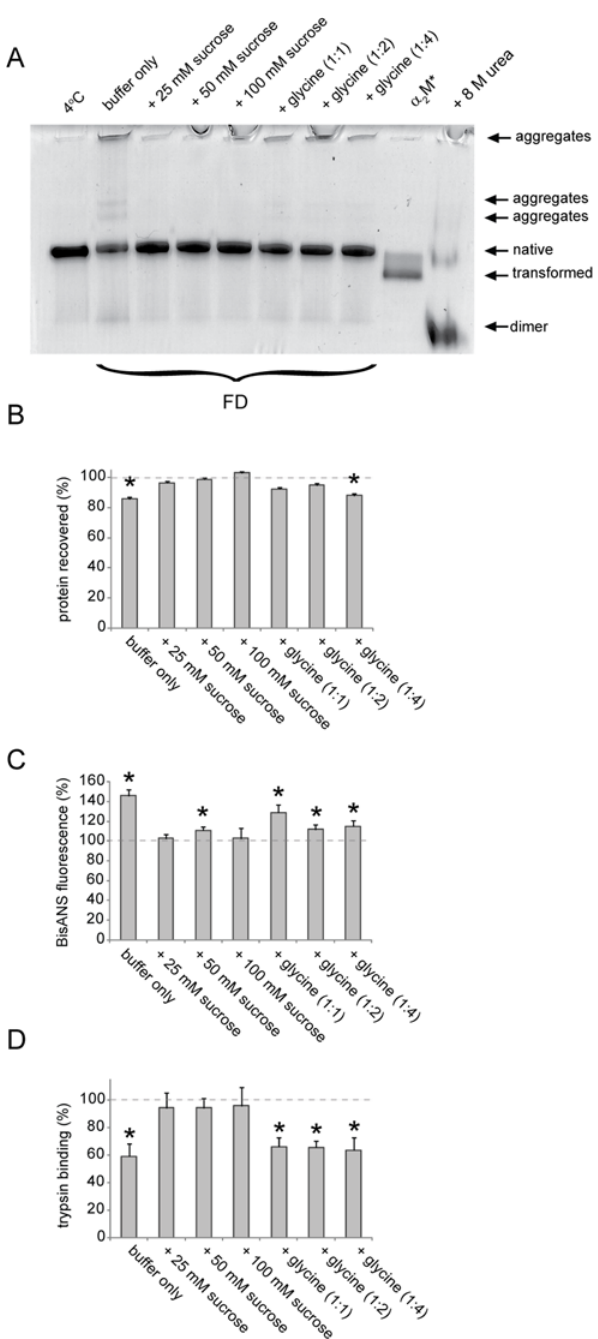
Fig 7. The effect of sucrose or glycine on the preservation of native α 2 M characteristics after lyophilization. (A) Image of a native PAGE (3 – 8% Tris-acetate) gel showing α 2 M stored in 20 mM phosphate buffer, pH 7.4 (4°C, 2 months) or after lyophilization and storage at -20°C for 7 days prior to reconstitution. α 2 M was lyophilized from buffer only, with sucrose present at the indicated concentrations, or with glycine at the indicated mass ratios ( α 2 M-to-glycine). As references, the positions of native α 2 M, transformed α 2 M and dimeric α 2 M (generated by incubation with 8 M urea) are shown. (B) Recovery of soluble the conditions described in (A) as assessed by the BCA assay. (C) Corresponding bisANS fluorescence measurements for α 2 M after lyophilization from the conditions described in (A). The results shown are the values of the mean bisANS fluorescence (n = 3 ± SD) in AFU.